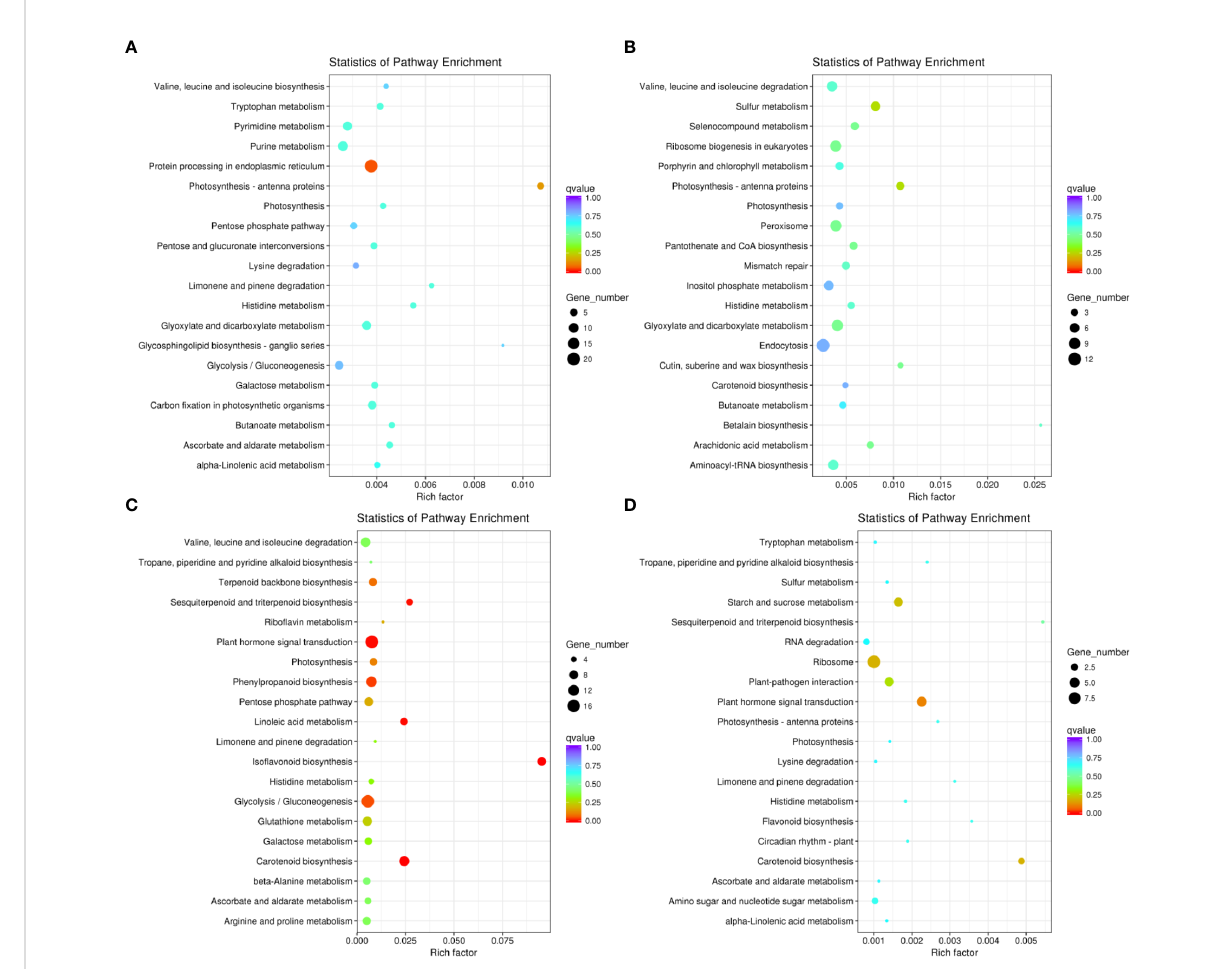
FIGURE 4 KEGG functional classi fi cation of the DEGs. The sizes of the spots represent the number of genes, and the colors represent the q-value. KEGG functional classi fi cation of the DEGs in N4 (A) , N8 (B) , M4 (C) , and M8 (D) . N4 and N8 represent the comparison groups of the genes identi fi ed at 4 h and 8 h after treatment to 0 h in Adina. M4 and M8 represent the comparison groups of the genes identi fi ed at 4 h and 8 h after treatments to 0 h in Zhaodong.